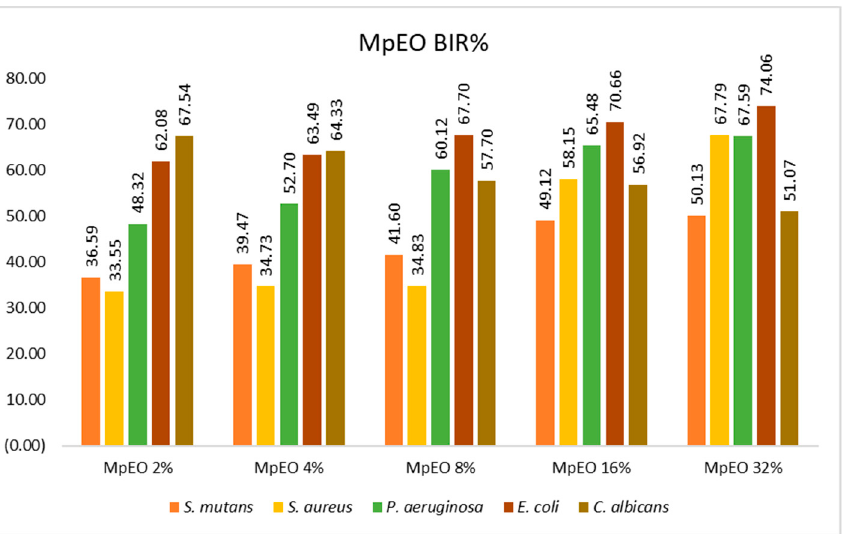
Figure 1. MpEO antimicrobial activity on the tested strains at different concentrations expressed as BIR%.